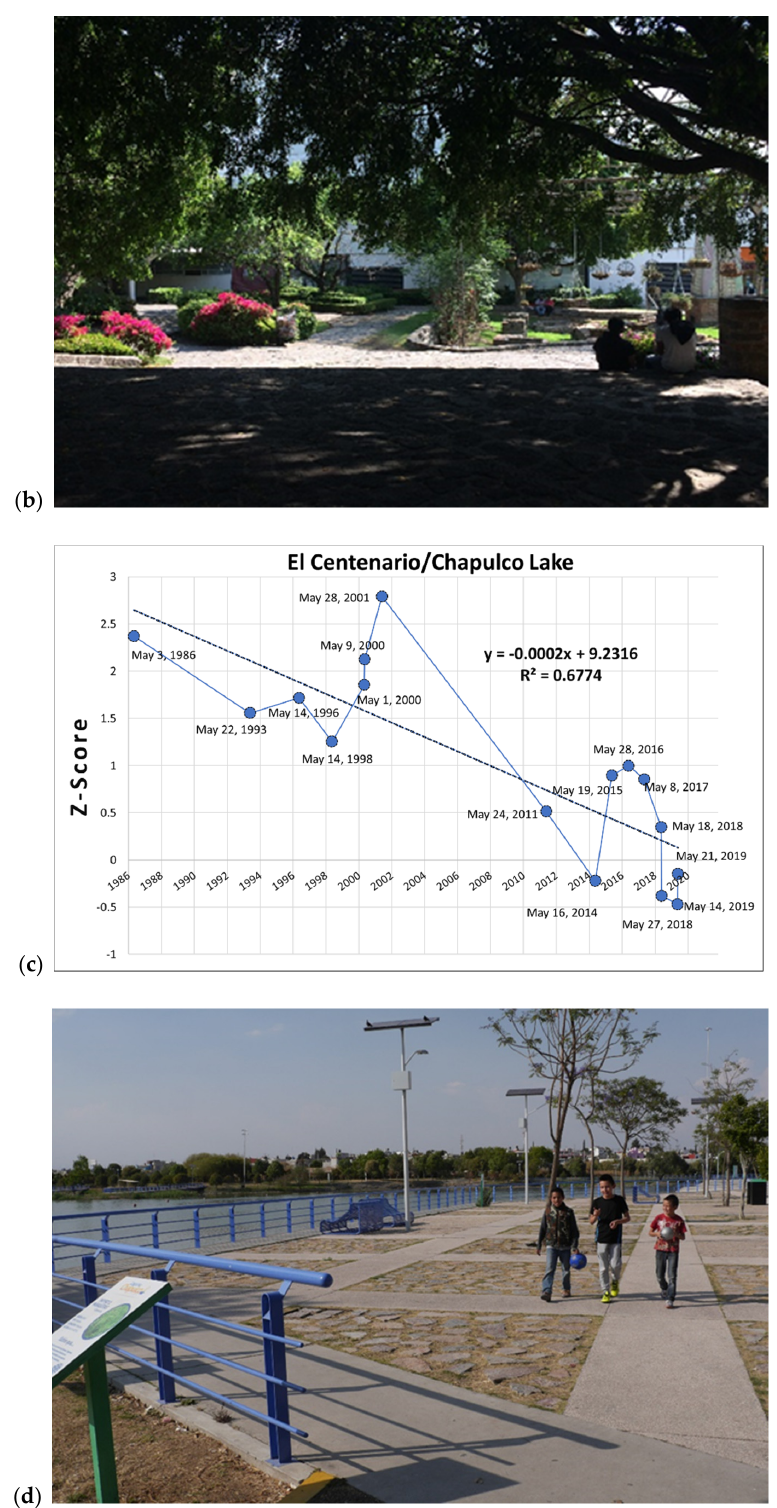
Figure 12. The graph ( a ) shows the change in the greenness of Paseo de San Francisco over the 34-year period and ( b ) is a photo of the park in April 2018. While ( c ) shows the change in greenness of El Centenario/Chapulco Lake Park over the 34-year period and in ( d ) shows a photo of the park in April 2018. The two pictures show that these two parks look very differently, Paseo de San Francisco is a very green city park with lush vegetation, while El Centenario/Chapulco Lake is dominated by impervious surfaces with limited shading and vegetation, and a large